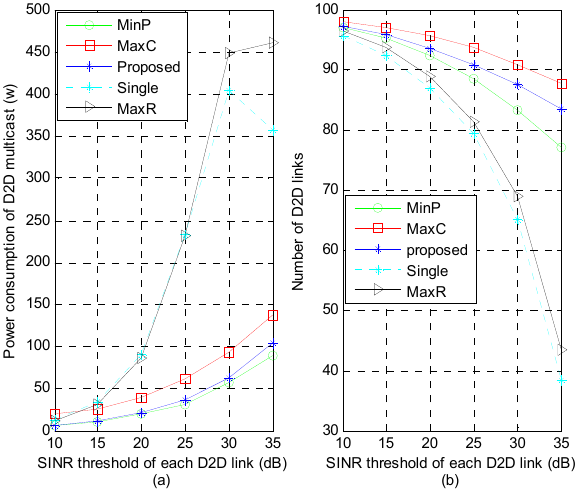
Figure 6. Power consumption and number of D2D links versus SINR threshold of each D2D link: ( a ) Impact of SINR requirement of D2D links on power consumption; ( b ) Impact of SINR requirement of D2D links on system capacity.